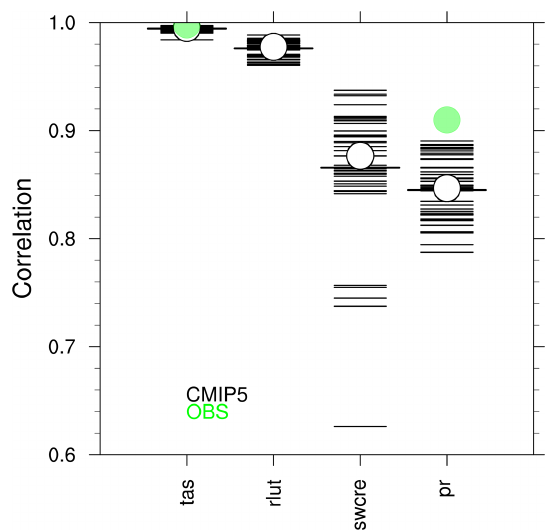
Figure 2. Centred pattern correlations for the annual mean clima- tology over the period 1980–1999 between models and observa- tions. Results for individual CMIP5 models are shown (thin dashes), as well as the ensemble average (longer thick dash) and median (open circle). The correlations are computed between the models and the reference dataset. When an alternate observational dataset is present, its correlation to the reference dataset is also shown (solid green circles). Similar to Fig. 9.6 of IPCC WG I AR5 chap. 9 (Flato et al., 2013) and produced with recipe_flato13ipcc.yml ; see details in Sect.